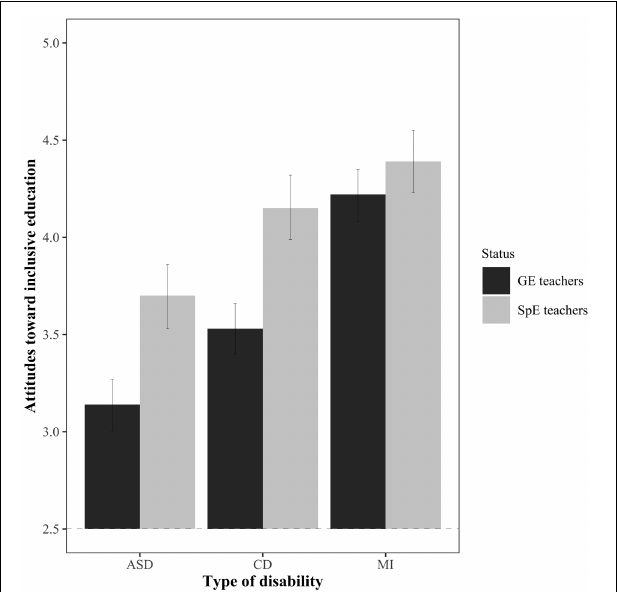
FIGURE 1 | The mean attitudes of participants depending on their status (GE, general education teachers; SpE, special education teachers) and the type of disability of students (ASD, autism spectrum disorder; CD, cognitive disorder; MI, motor impairment). Errors bars represent 95%